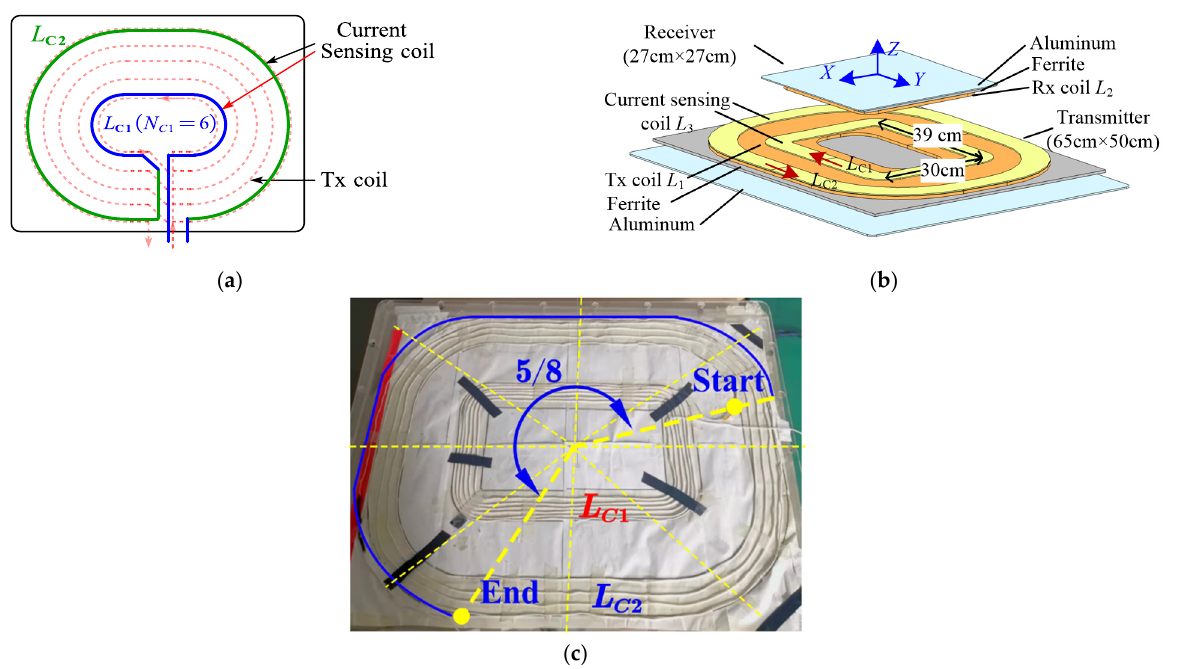
Figure 7. Asymmetric structure and dimensions of the coupler. ( a ) Two-dimensional graph of Tx pad, ( b ) three-dimensional graph of the coupler, and ( c ) practical configuration of the sensing coil.